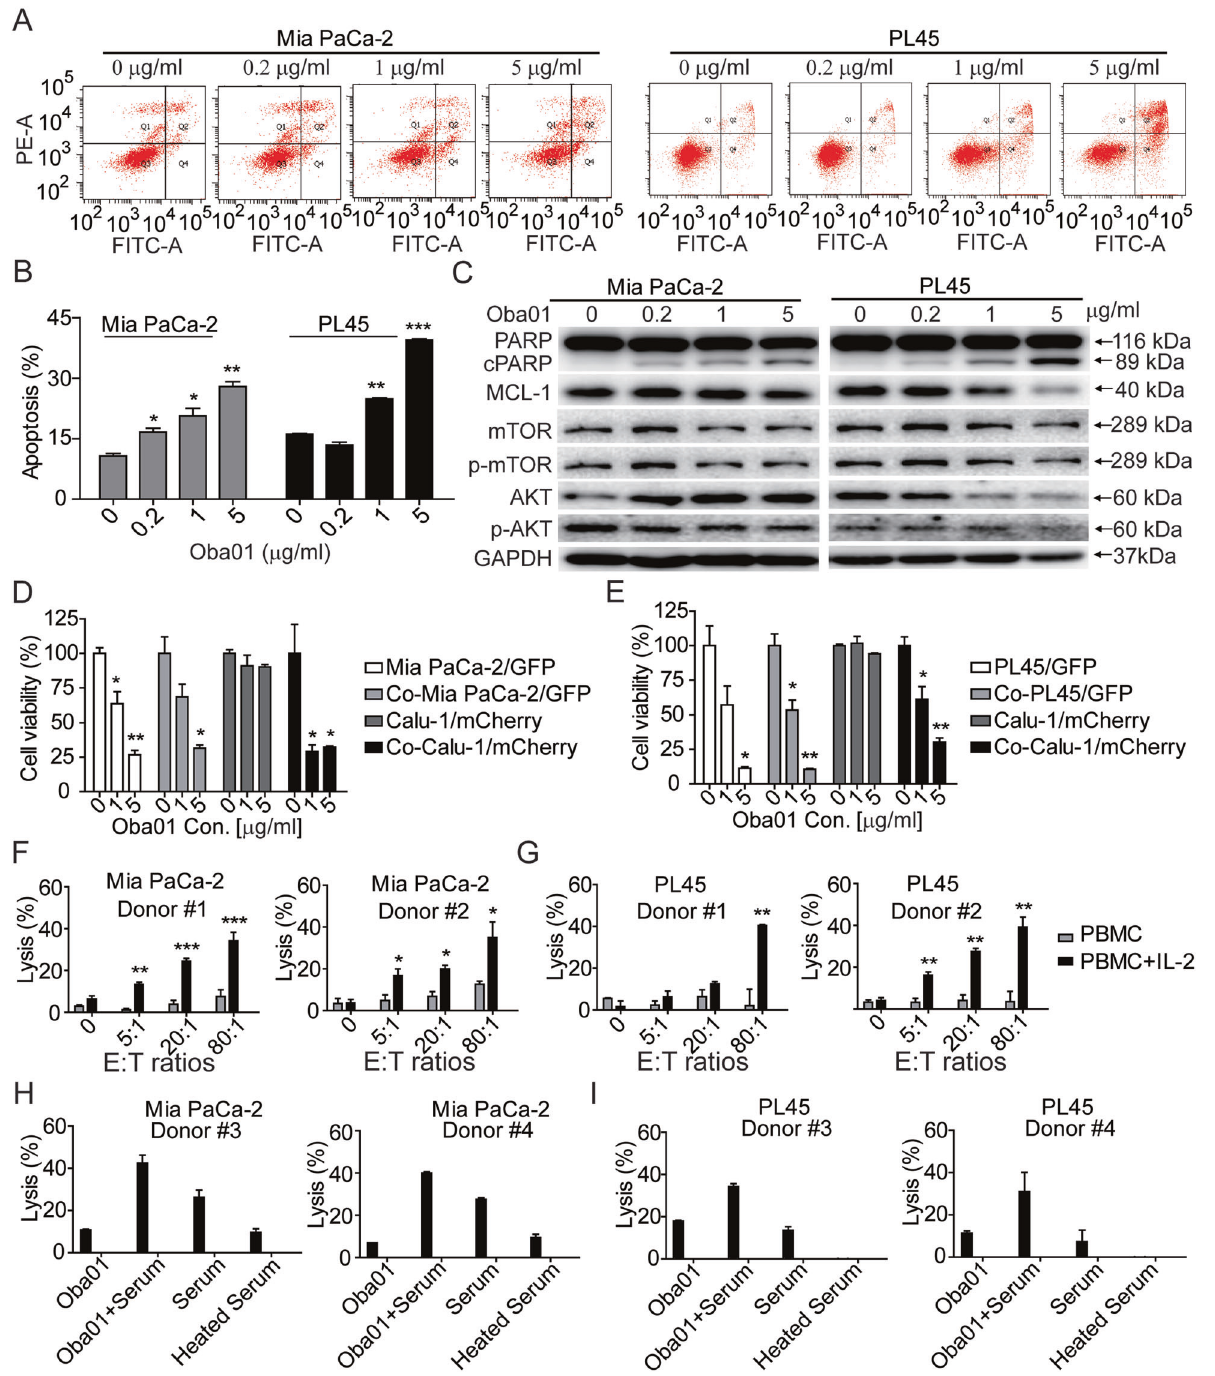
Fig. 3 Oba01 induced cell death in pancreatic cancer cells. A , B Mia PaCa-2 and PL45 cells were treated with different concentrations of Oba01 (as indicated) for 48 h. Cell apoptosis was assessed by fl ow cytometry and percent of Annexin V/PI-positive cells are depicted in bar charts. C Cell lysates were subjected to immunoblotting with antibodies to p-AKT, AKT, P-mTOR, mTOR, MCL-1, PARP, or with antibodies to GAPDH as the loading control. D , E Oba01 demonstrated a strong bystander killing activity. Mia PaCa-2/GFP cells ( D ) or PL45/GFP cells ( E ) and Calu-1/mCherry cells were cultured alone or mixed at a ratio of 2.5:1 and cocultured (Co) overnight, followed by treatment with various concentrations of Oba01 for 5 days. Live cells was detected by fl ow cytometry. F , G Oba01 mediated the ADCC activity. Mia PaCa-2 ( F ) and PL45 cells ( G ) were plated in a 96-well plate, and IL-2-activated human PBMCs were added at different E:T ratios (E: PBMC, T: Mia PaCa-2 or PL45 cells) to detect the ADCC. H , I Oba01 mediated the CDC activity. Human serum was added to Mia PaCa-2 ( H ) and PL45 cells ( I ) in the presence or absence of Oba01. Heat-inactivated serum was used as a negative